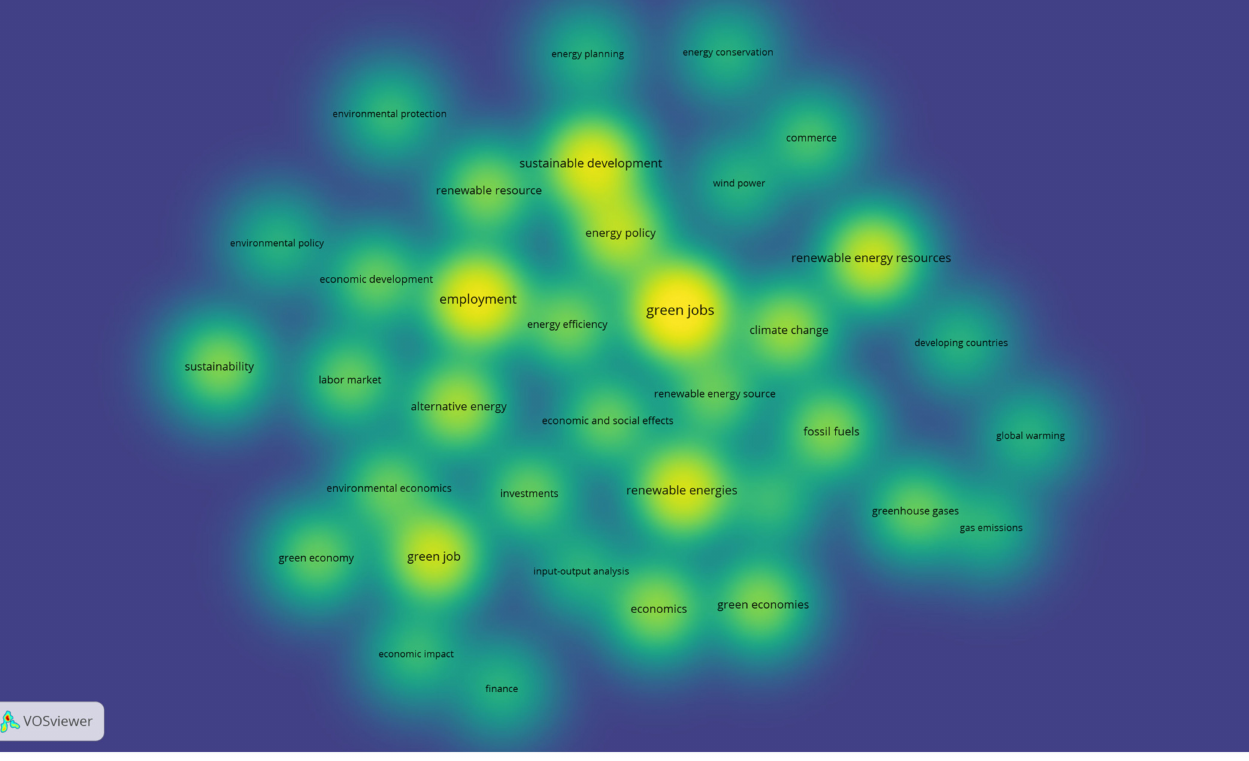
Figure 5. Item density visualization. Source: Authors’ elaboration in VOSviewer software (1.6.18